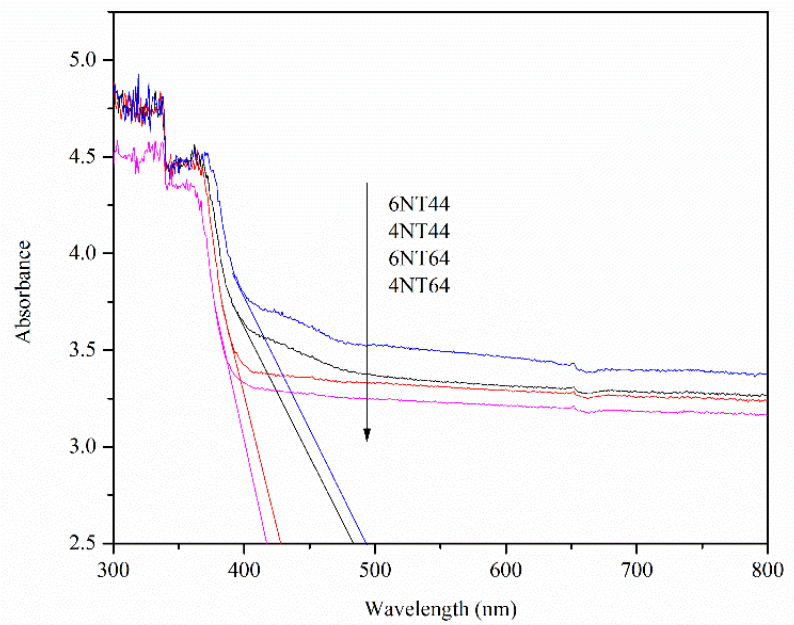
Fig. 6. UV–Vis spectra for different N-doped TiO2 sample. Table 3: Percentage atomic concentration and binding energies of nitrogen for different N-doped TiO 2 sample Sample N 1s (% at. Conc)